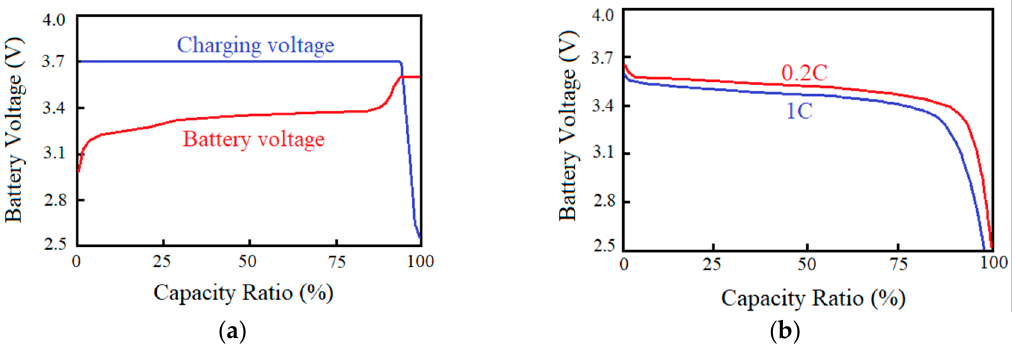
Figure 4. The measured battery charge and discharge characteristics: ( a ) charge characteristics and ( b ) discharge characteristics. ( b ) discharge